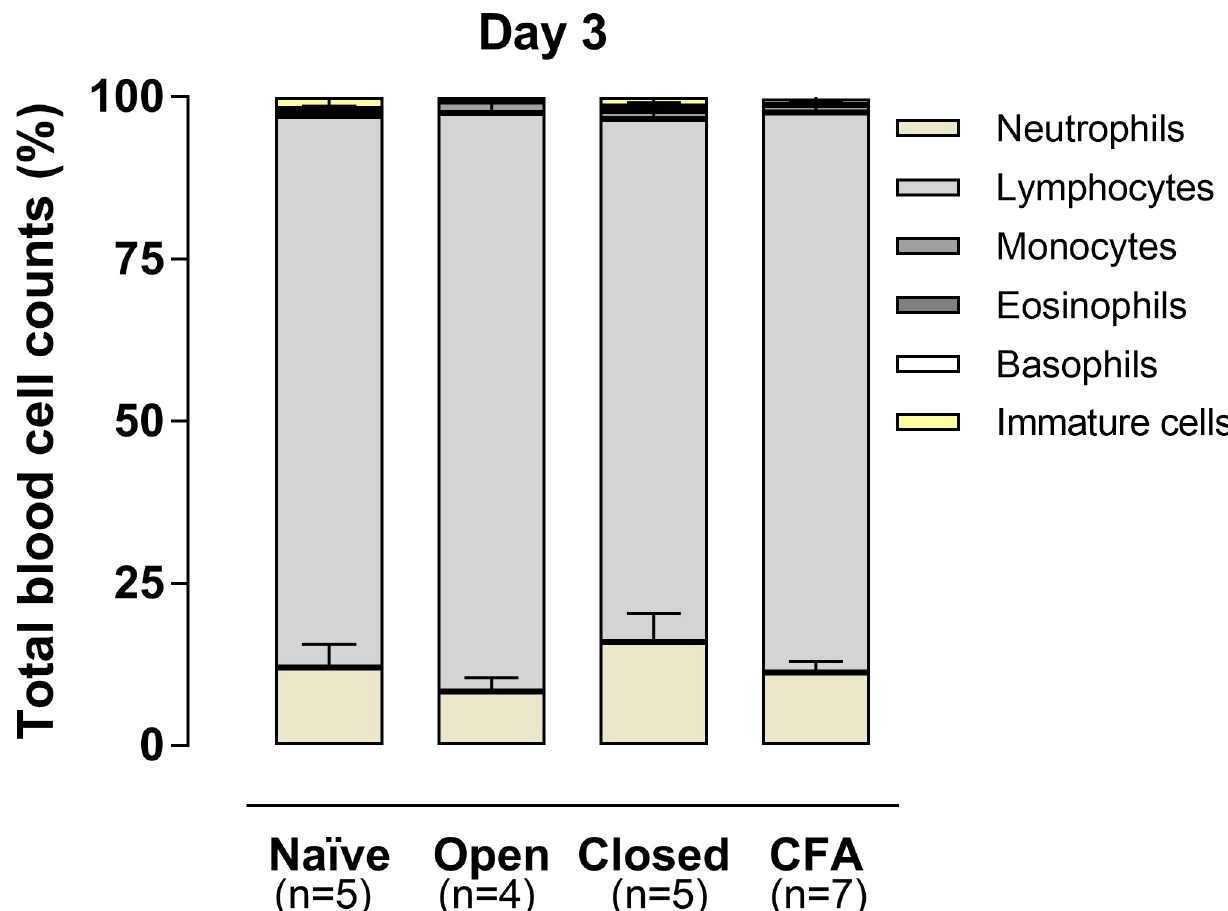
Fig 3. Total blood cell counts evaluated on the third day. The columns represent the mean of 5–7 experiments, and the vertical lines indicate the standard error of mean (P > 0.5; Kruskal-Wallis plus Dunn’s test).